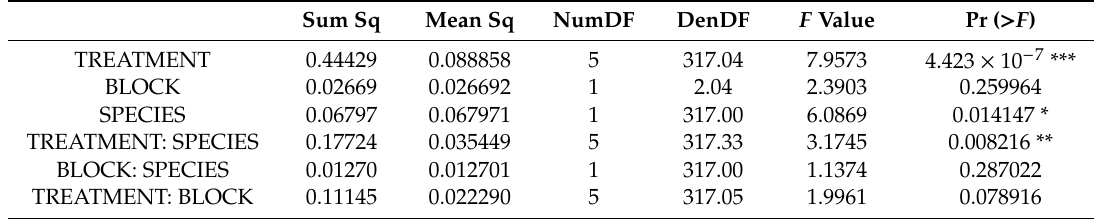
Table A4. Type III Analysis of Variance Table with Satterthwaite’s method.